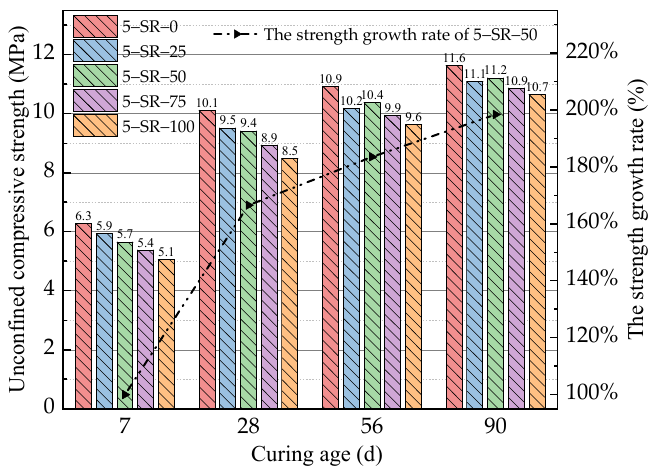
Figure 7. Test results of unconfined compressive strength at various slag replacement rates.